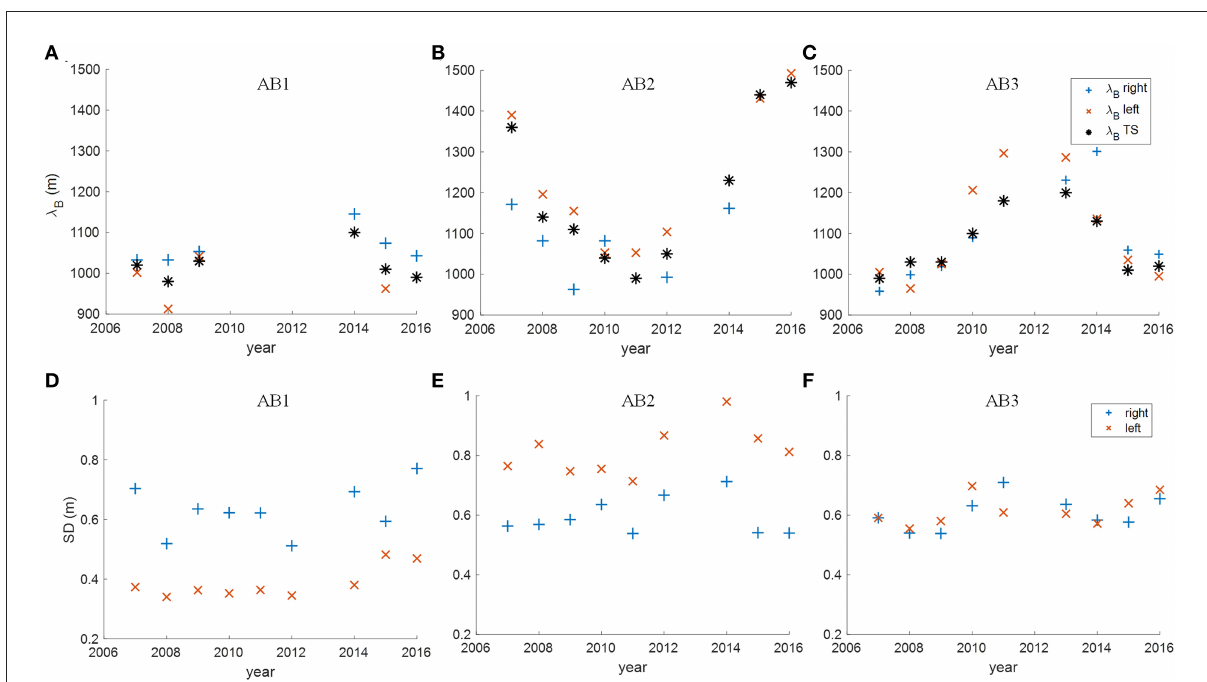
FIGURE8 (A–C) Bar wavelength and (D–F) standard deviation over the years plotted respectively for the investigated sections AB1 (A, D) , AB2 (B, E) , and AB3 (C, F) . Values calculated based on the outer right (left) elevation profiles are shown as blue + (red × ) and values calculated based on the transverse slope are marked with black *.